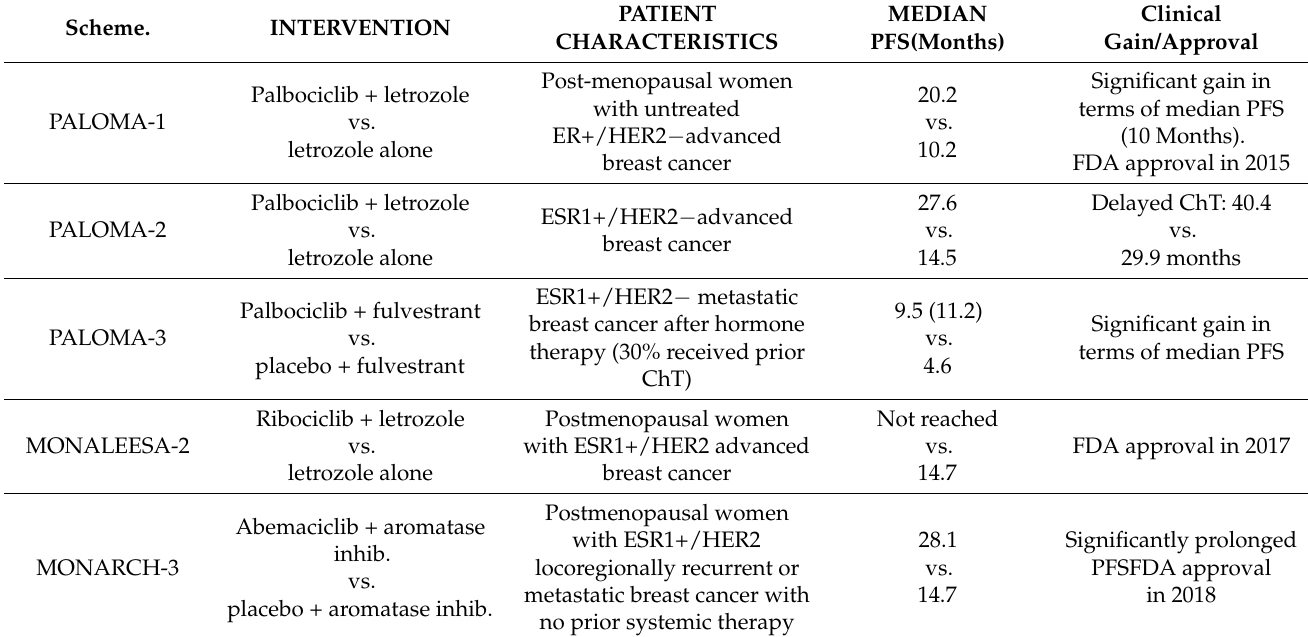
Table 1. Synthesis of the registrative clinical trials of cyclin inhibitors in metastatic breast cancer.